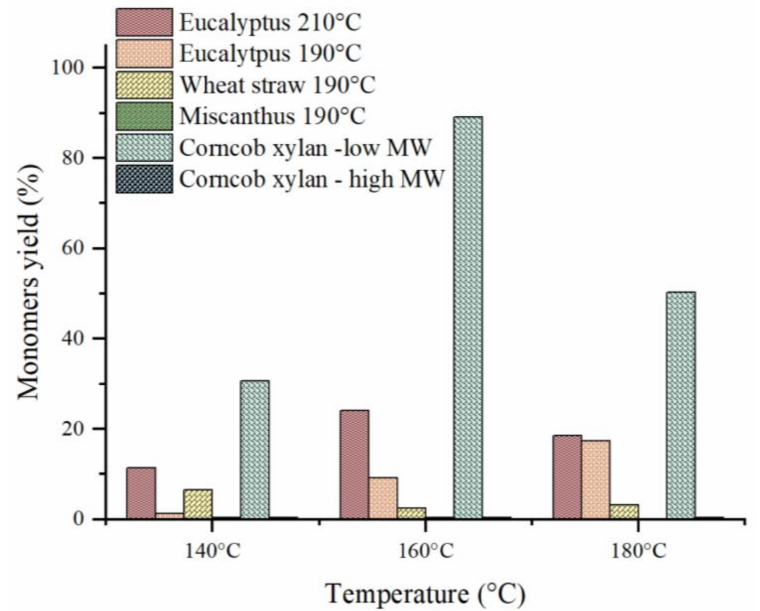
Figure 5. Monomer yields during catalytic